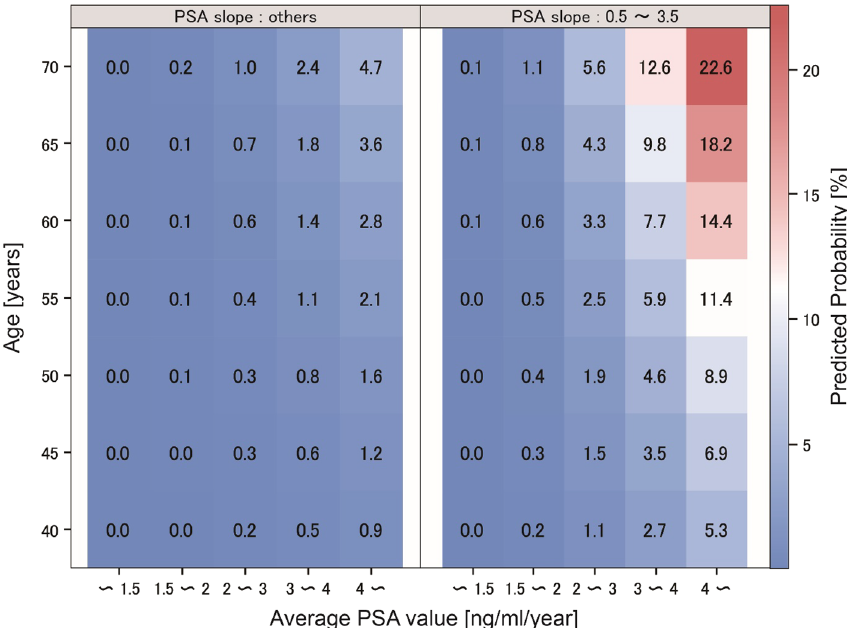
Figure 4. Heat map based on the developed prediction model. The heat map shows the predicted probability of developing prostate cancer in a given subject according to age, PSA slope, and average PSA value. PSA prostate- specific